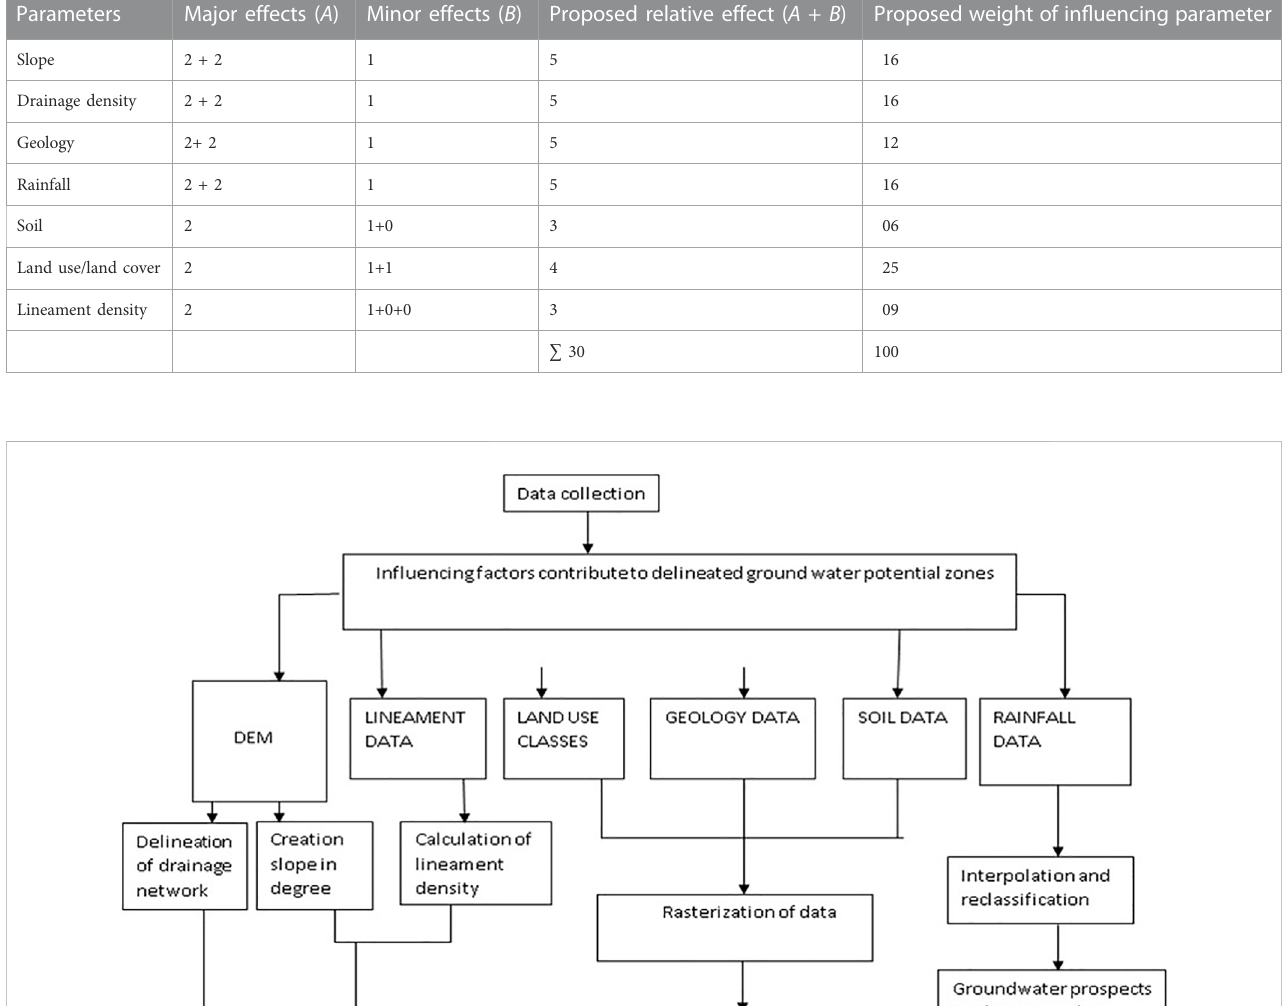
TABLE 2 Values of major, minor, and relative effects and proposed weights of in fl uencing parameters.